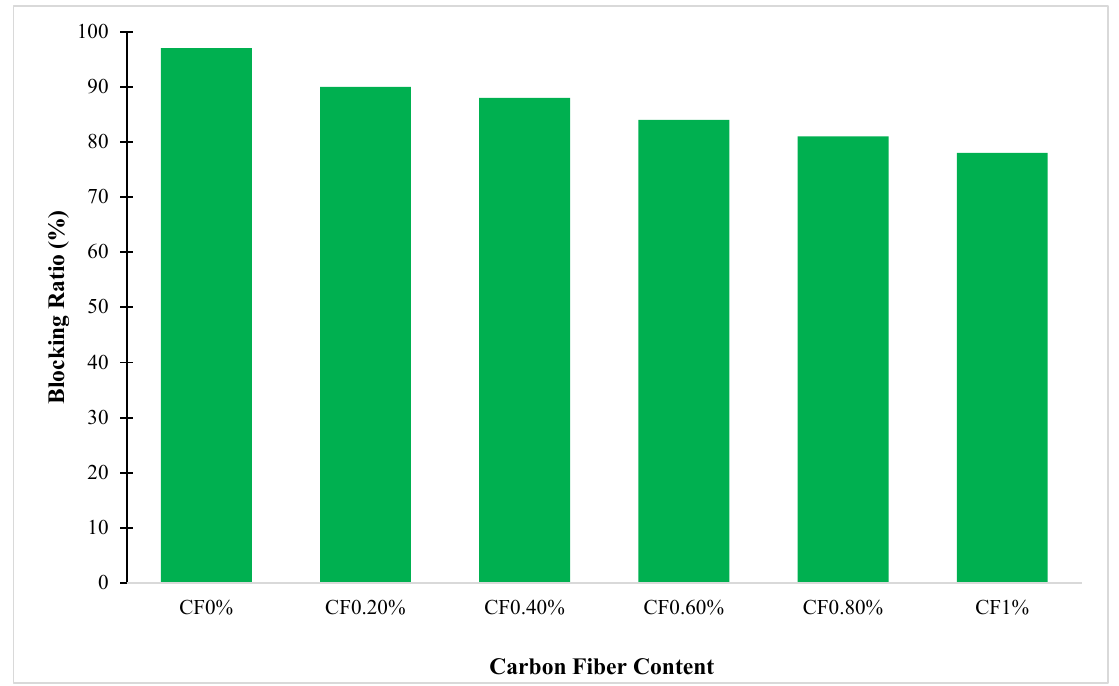
Figure 3. L-Box test.